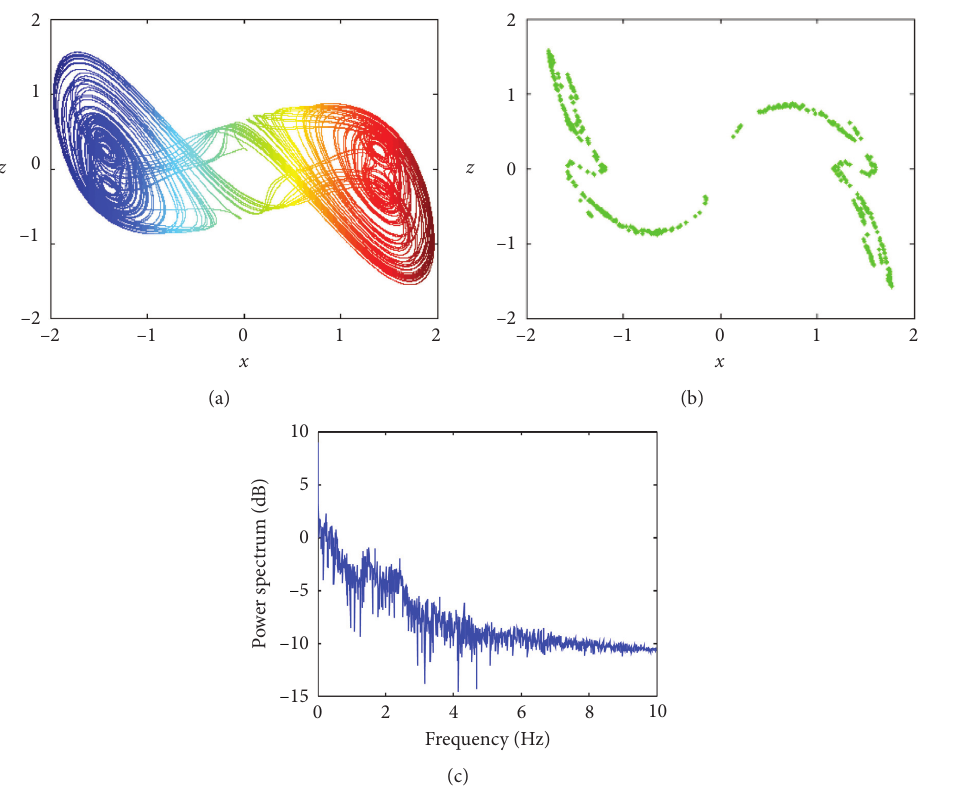
Figure 1: (a) The composite six-scroll hidden chaotic attractor. (b) The corresponding Poincar´e mapping on y � 0 section. (c) The corresponding power